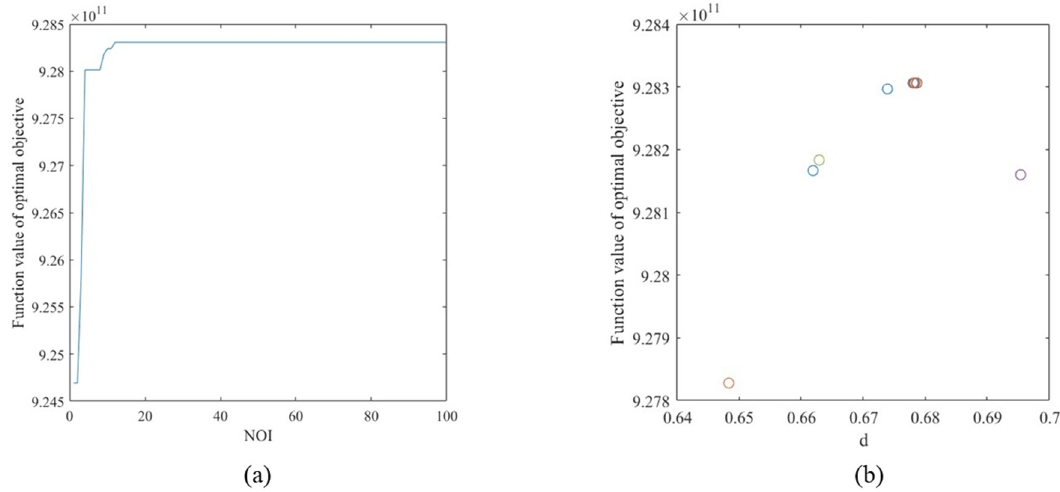
Figure 17. Global optimal value of the target function using the PSO algorithm: ( a ) The relationship between the number of PSO iteration and the optimal function value; ( b ) The optimal function value corresponds to the station spacing d .